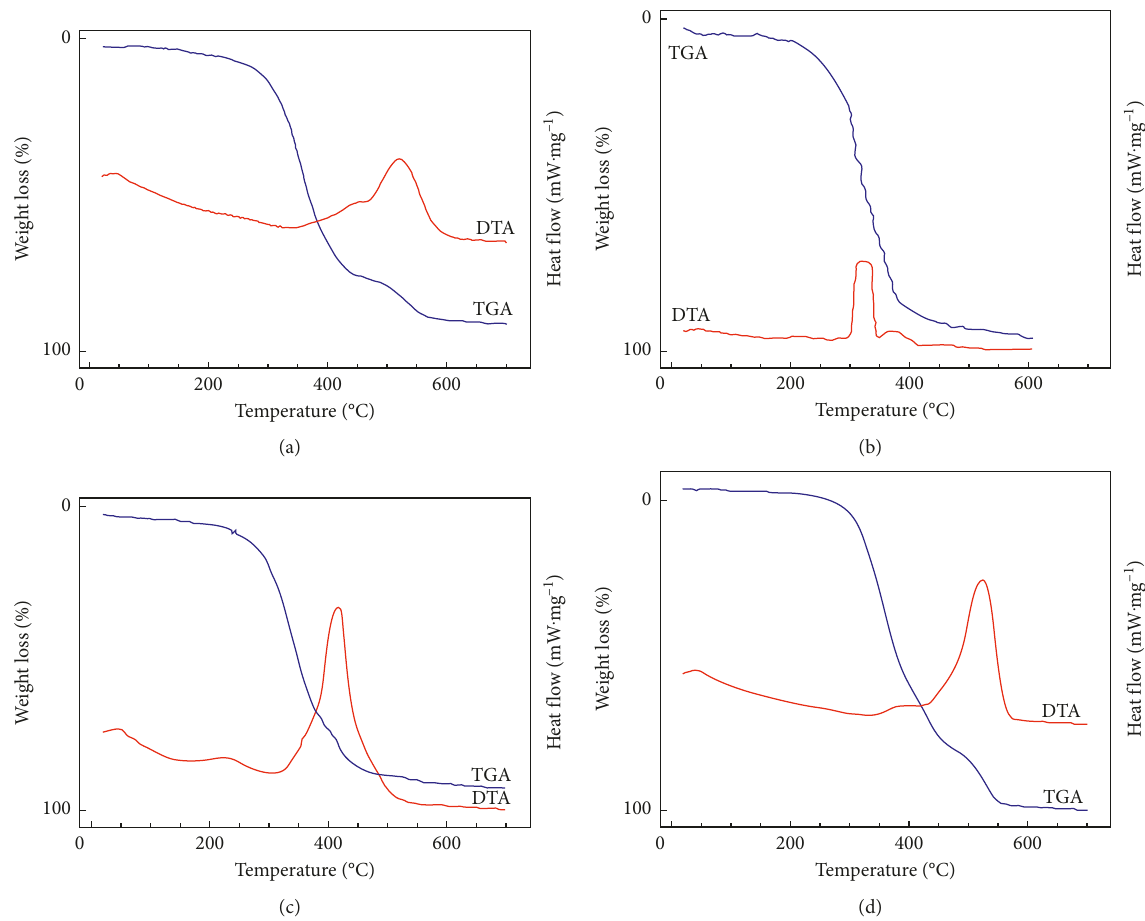
Figure 9: TGA and DTA thermograms of (a) poly(DEAMSt0.49-co-BMA), (b) poly(DEAMSt0.49-co-BMA)-Co, (c) poly(DEAMSt0.49-co- BMA)-Ni, and (d) poly(DEAMSt0.49-co-BMA)-Zn.